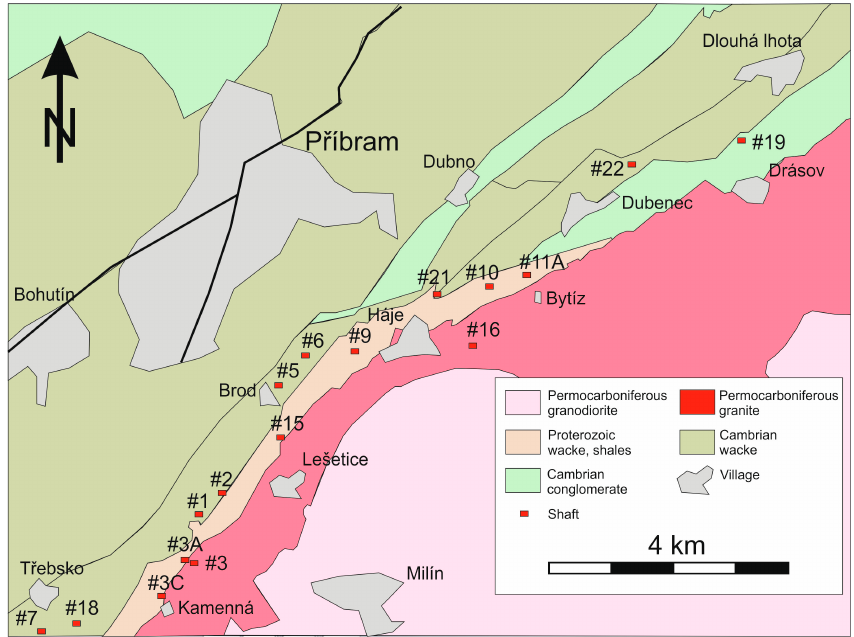
Figure 1. Simplified geological map of the main part of the P ř íbram uranium and base-metal district.